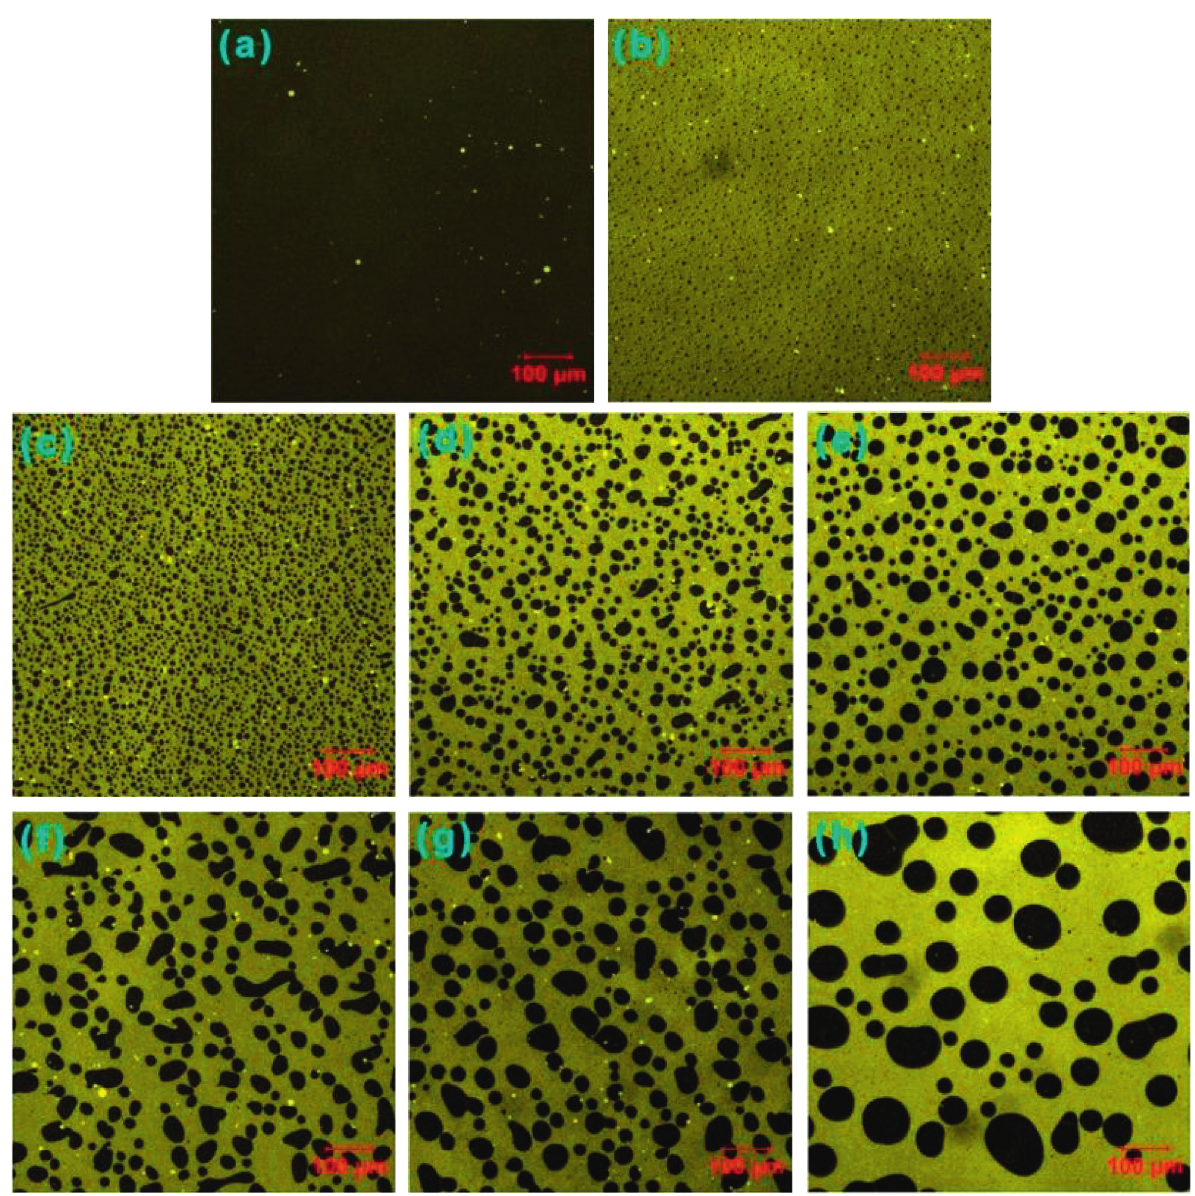
Figure 7: LSCM images of EA during curing at 150 ° C: 0min (a), 3min (b), 5 min (c), 10min (d), 15min (e), 20min (f), 30min (g), and 60min (h)